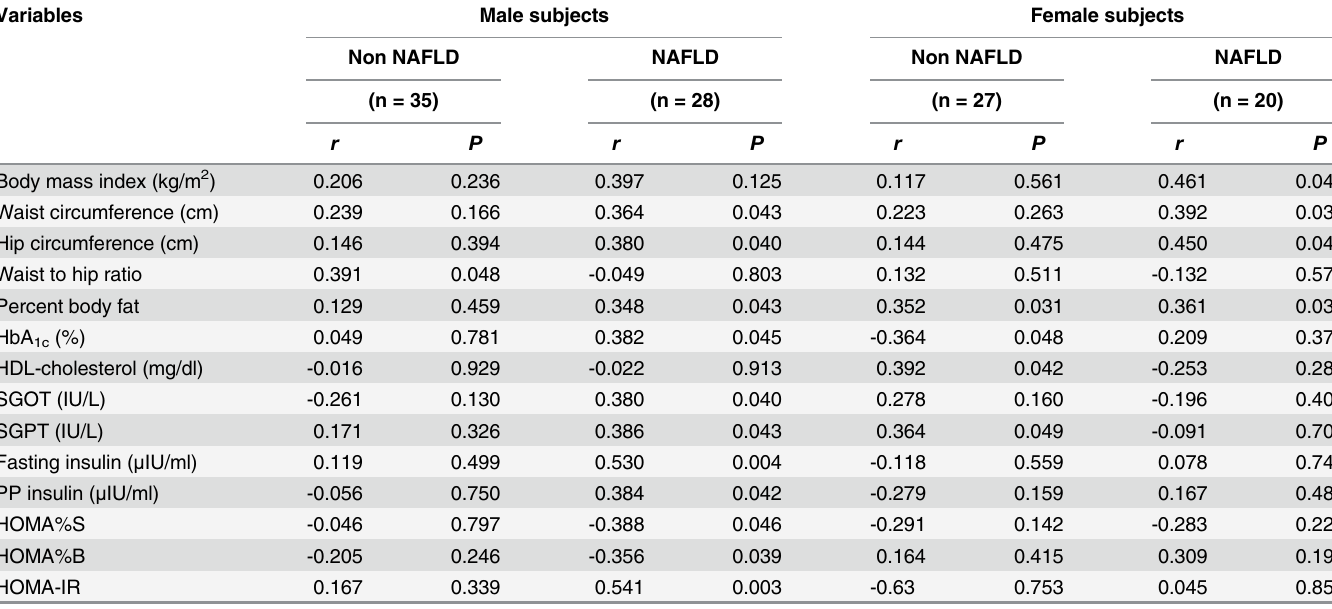
Table 3. Pearson ’ s correlation between serum leptin levels and study variables, by gender in NAFLD and non NAFLD groups.